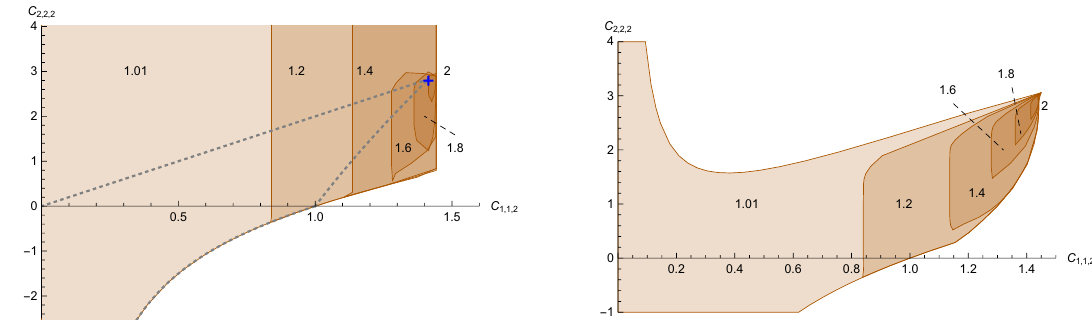
Figure 10 . Left: bounds for (cid:3) = 40 and for the gaps (cid:1) keeping the other gaps just above their respective unitarity bounds. The allowed region for given (cid:1) contains the allowed regions for larger values of (cid:1) [0 ; 0]